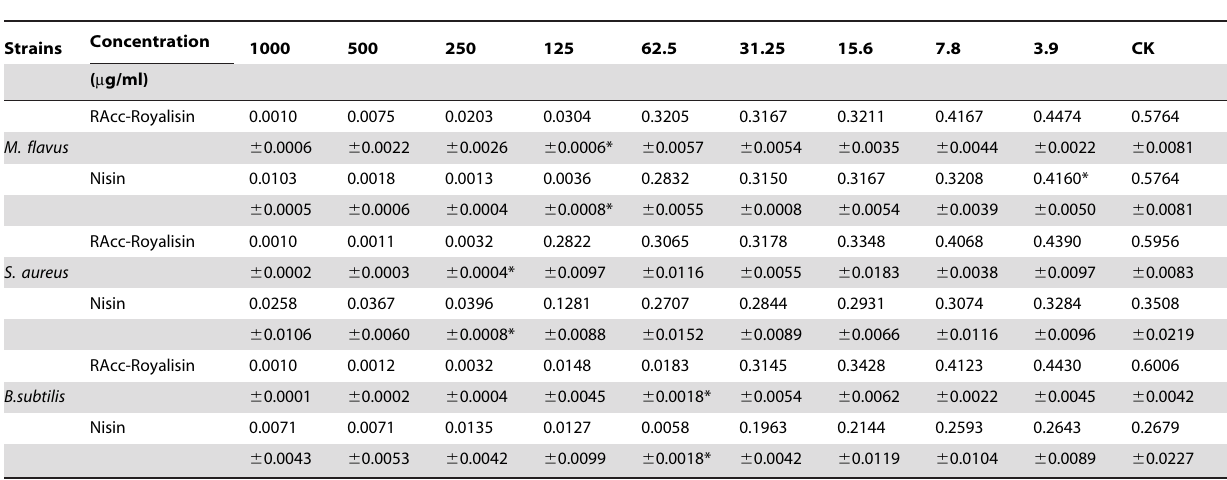
Table 1. The D OD 600 (mean 6 SD) value of RAcc-royalisn and nisin against three Gram-positive bacterial strains at different